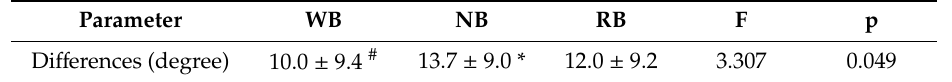
Table 3. Comparison of di ff erences between pelvic incidence and lumbar lordosis in each